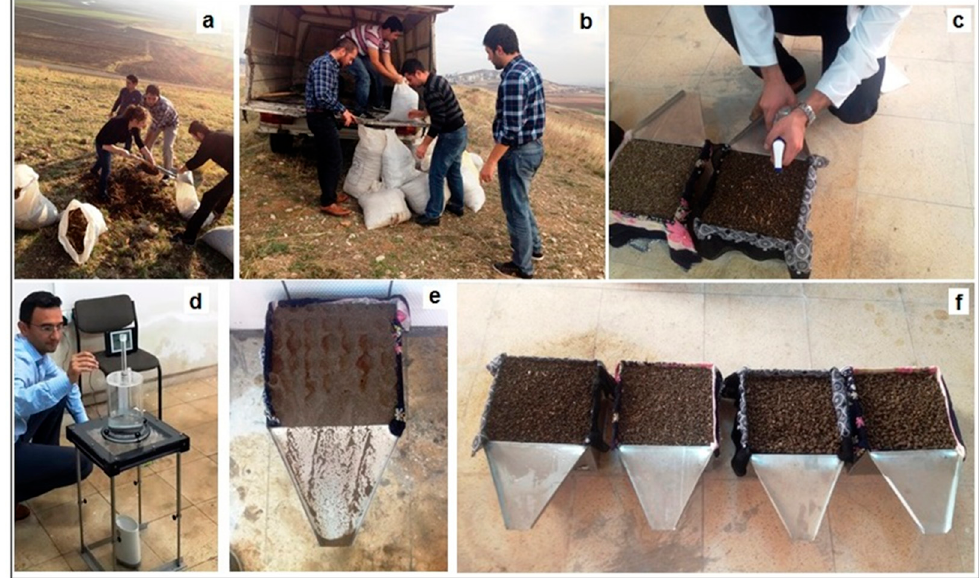
Figure 1. Soil sampling procedure and rainfall simulations under laboratory conditions. ( a ) Study area; ( b ) soil sampling; ( c ) polymer spraying; ( d ) mini-rainfall simulator; ( e , f ) rainfall simulation plots.